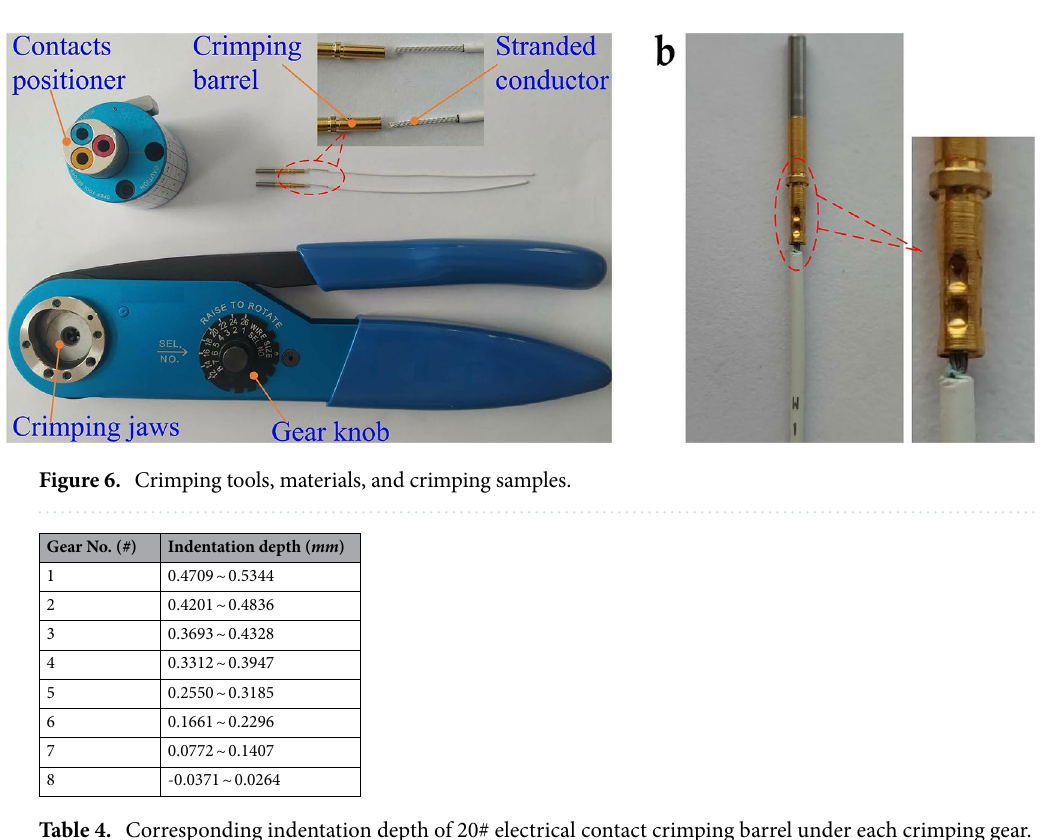
Table 4. Corresponding indentation depth of 20# electrical contact crimping barrel under each crimping gear.